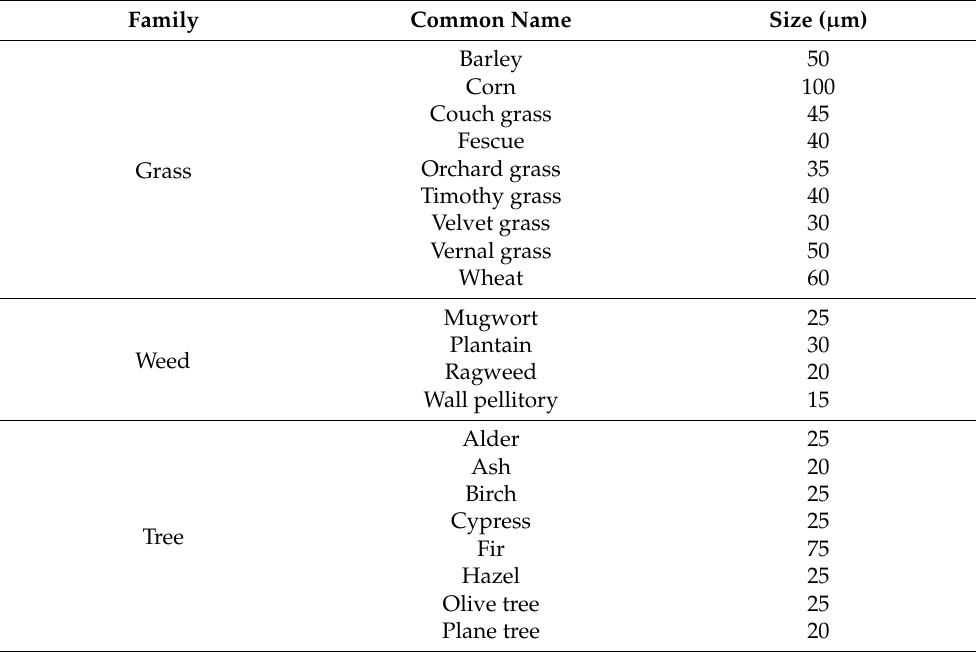
Table 1. Pollen species and sizes (the sizes were rounded to the closest 5 µ